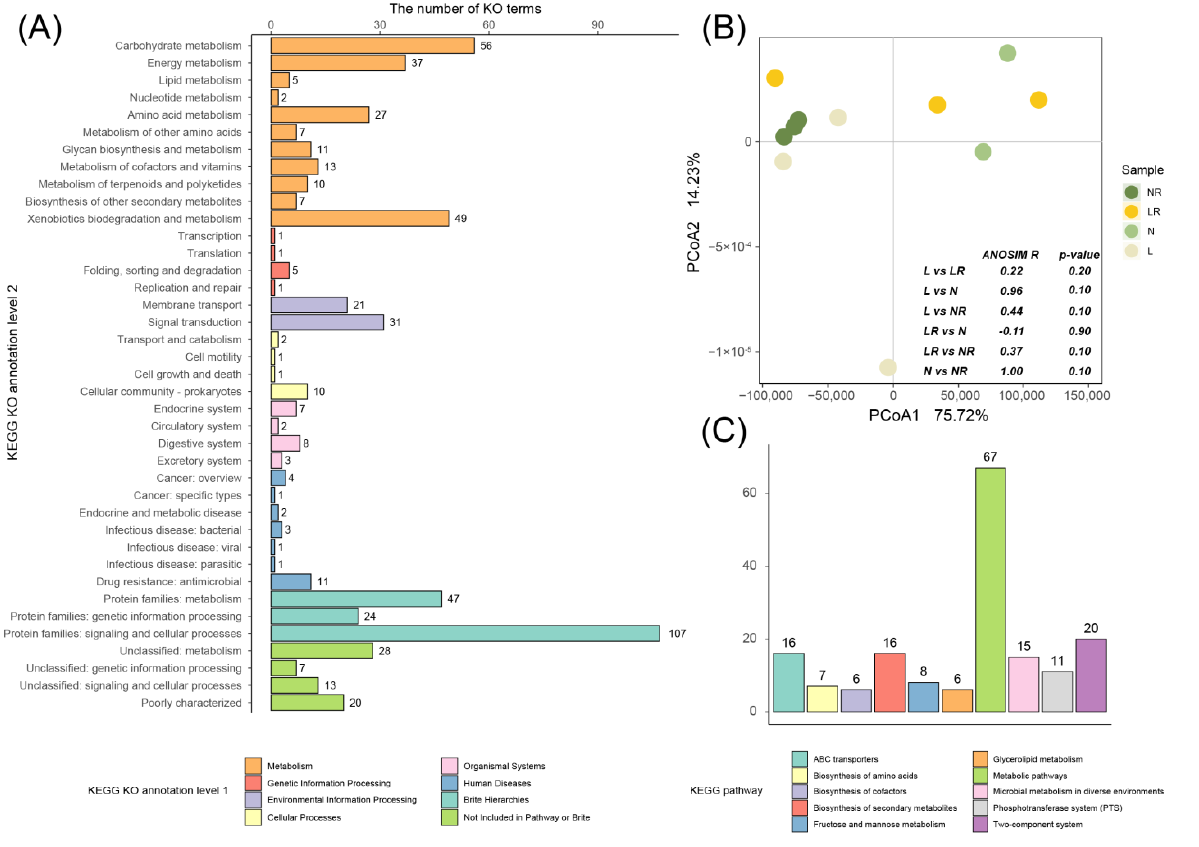
Figure 6. Prediction of function of soil bacteria associated with normal-growth and limited-growth highbush blueberry plants. NR-rhizosphere soil of normally growing plants; LR-rhizosphere soil of plants with limited growth; N-bulk soil of normally growing plants; L-bulk soil of plants with limited growth. ( A ) Distribution of KO entries for predicted gene function. ( B ) Principal co-ordinates analysis of predicted gene function of bacteria. ( C ) Predicted distribution of KEGG pathway cate- gories.